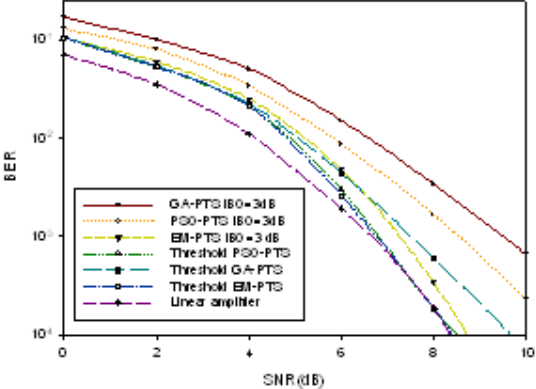
Fig. 7 BER performance of MC-CDMA system with EM